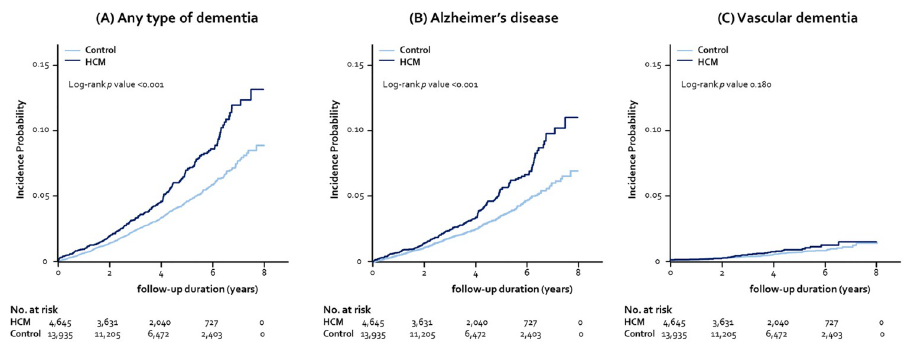
Fig 3. Kaplan-Meier curves for incidence probability of any dementia, AD, and VaD. The incidence probability of any type of dementia (A) and AD (B) tended to increase in patients with HCM, compared with controls. However, there was no significant differences in the incidence probability of VaD (C) the two groups. Abbreviations as Figs 1 and 2.